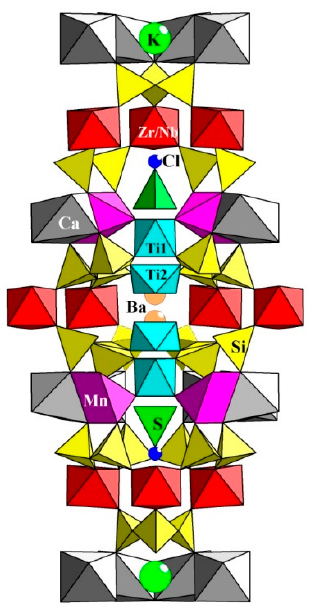
Figure 10. The crystal structute of a Nb,Ti-rich EGM from the Kovdor phlogopite deposit viewed along (210) [68].